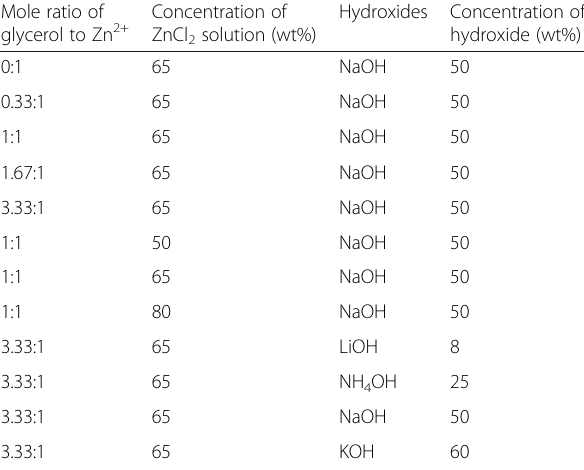
Table 1 The conditions of preparation of the ZnO